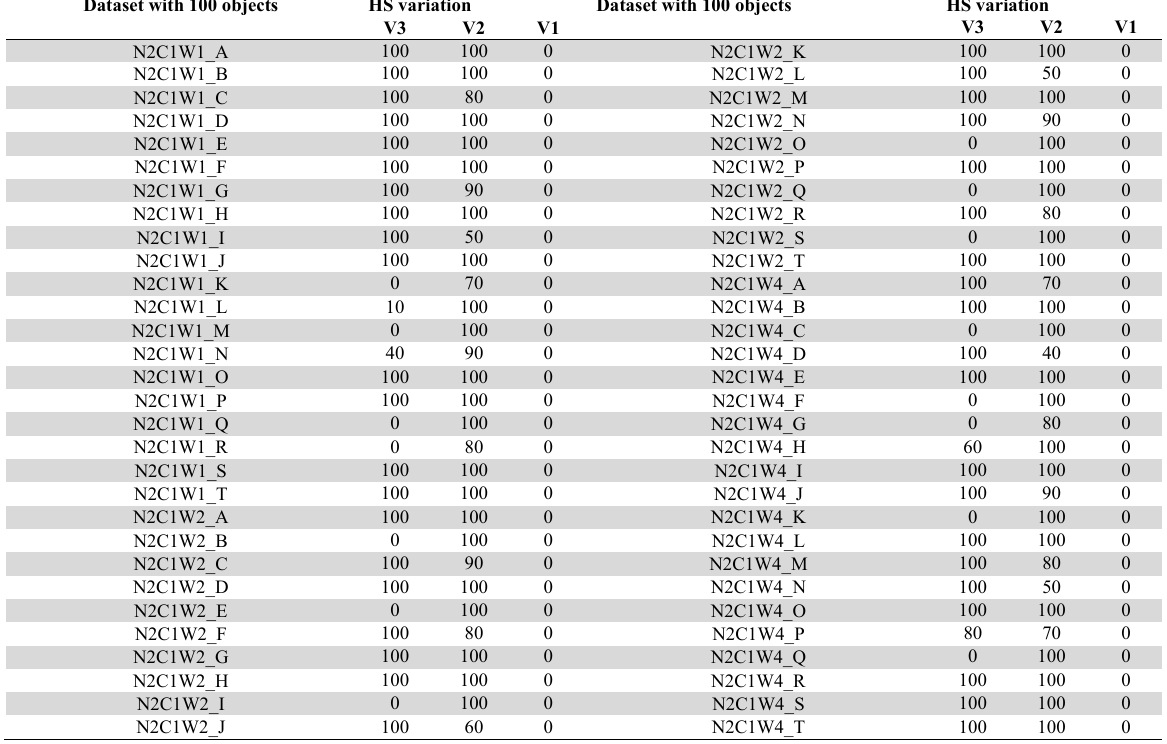
Success rate of proposed HS variations for 60 instances with 100 objects Dataset with 100 objects